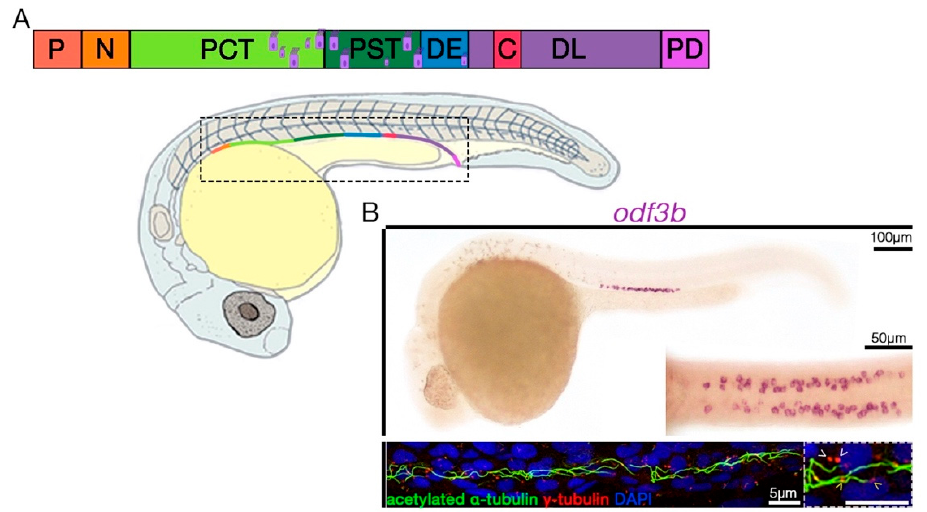
Figure 3. The zebrafish embryonic kidney contains a population of MCCs. ( A ) The nephron is comprised of several segments with specialized cell types (color coded), and MCCs are dispersed mainly in the proximal straight tubule (PST) region but also develop within the adjacent proximal convoluted tubule (PCT) and distal early (DE) segment. The schematic is representative of a 24 hpf (28 ss) animal. Other abbreviations: P, podocyte; N, neck; DL, distal early; CS, corpuscles of Stannius; PD, pronephric duct. ( B ) Whole-mount in situ hybridization to detect odf3b transcripts of a 24 hpf animal ( top ), which marks differentiating MCCs. Inset is a dorsal view of the pronephros, where individual MCCs are visible in both nephrons. Immunofluorescence ( bottom ) images of cilia ( α -tubulin) and basal bodies ( γ -tubulin) reveal both ciliated (white arrowheads) and unciliated (yellow arrowheads) basal bodies.